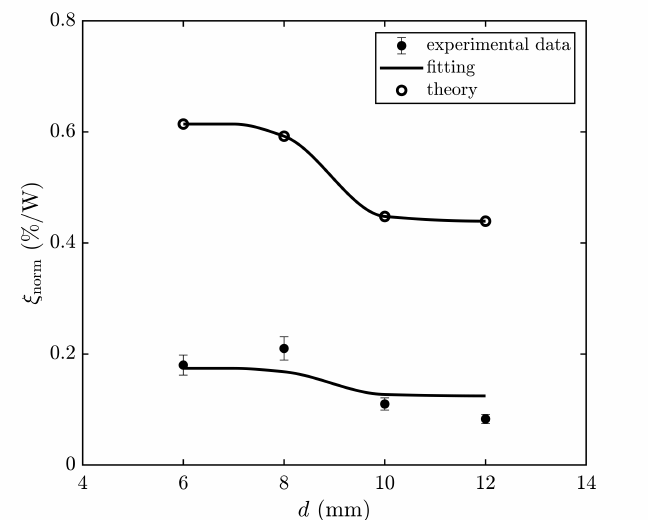
Figure 7. Dependence of energy efficiency of AO modulator on electrode width d of ultrasound